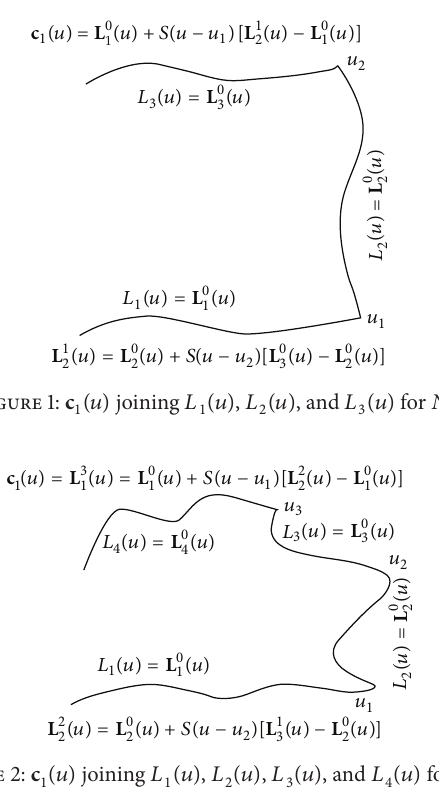
Figure 2: c 1 (𝑢) joining 𝐿 1 (𝑢) , 𝐿 2 (𝑢) , 𝐿 3 (𝑢) , and 𝐿 4 (𝑢) for 𝑁 = 14